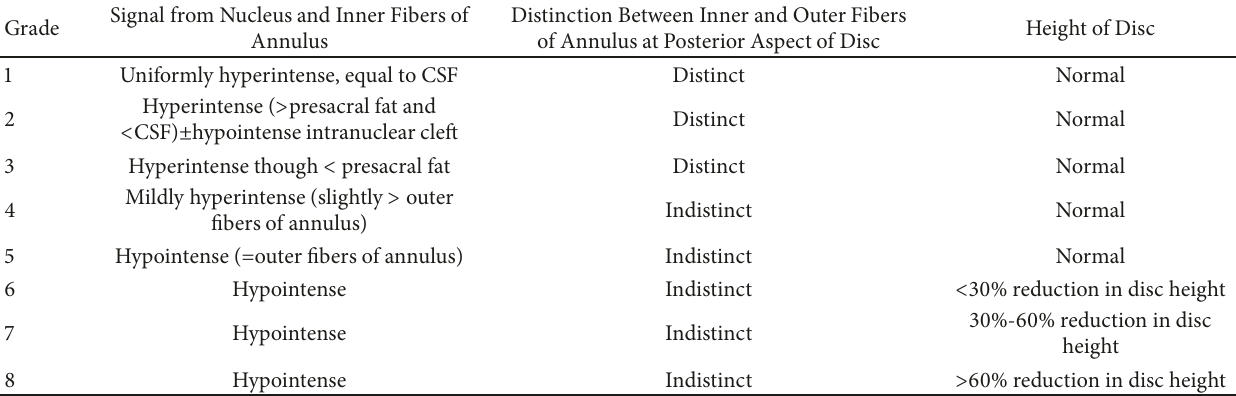
Table 3: The Modified Grading System for Lumbar Disc Degeneration ∗ . This material is used after author’s permission [17].